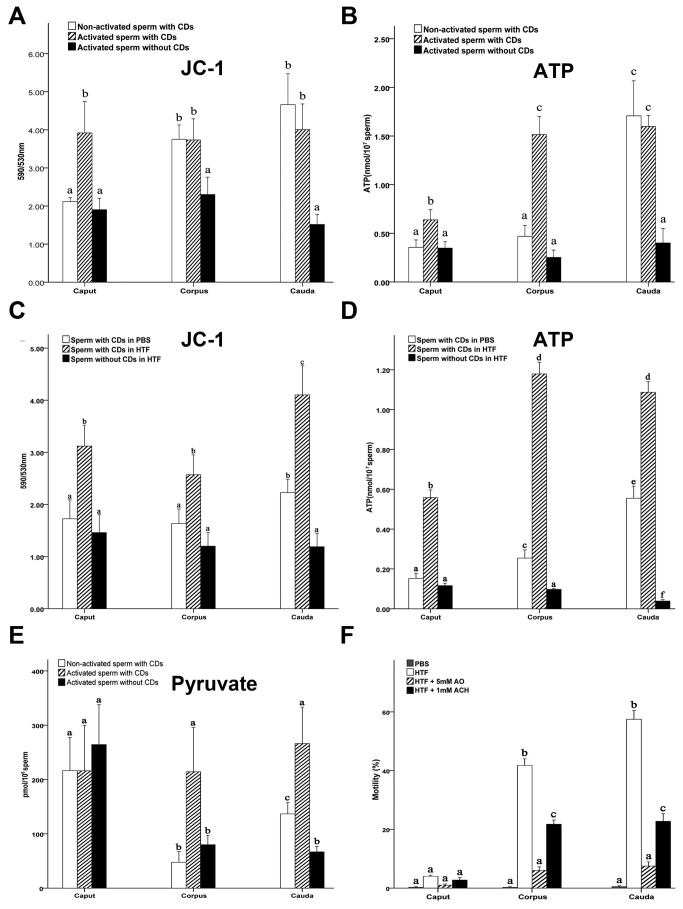
CDs appear to be required for normal mitochondrial activation and ATP production during epididymal sperm maturation.(A) Mitochondrial membrane potential in murine caput, corpus and cauda epididymal spermatozoa with or without CDs. Data are presented as mean ± SEM. Bars with different letters are significantly different (p<0.05, n=5). (B) ATP levels in murine caput, corpus and cauda epididymal spermatozoa with or without CDs. Data are presented as mean ± SEM. Bars with different letters are significantly different (p<0.05, n=5). (C) Mitochondrial membrane potential in monkey caput, corpus and cauda epididymal spermatozoa with or without cytoplasmic droplets (CDs). Data are presented as mean ± SEM. Bars with different letters are significantly different (p<0.05, n=5). (D) ATP levels in monkey caput, corpus and cauda epididymal spermatozoa with or without CDs. Data are presented as mean ± SEM. Bars with different letters are significantly different (p<0.05, n=5). (E) Pyruvate levels in murine caput, corpus and cauda epididymal spermatozoa with or without CDs. Data are presented as mean ± SEM. Bars with different letters are significantly different (p<0.05, n=5). (F) Effects of 5mM Ammonium Oxalate (AO) and 1mM α-Chlorohydrin (ACH) on the development of progressive motility of murine caput, corpus and cauda epididymal spermatozoa. Data are presented as mean ± SEM. Bars with different letters are significantly different (p<0.05, n=4).